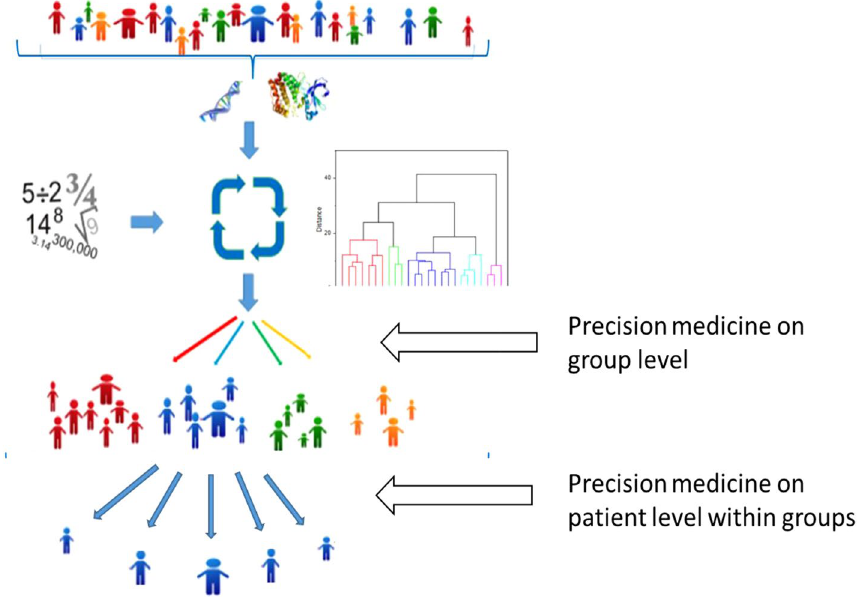
Figure 8. The ER modelling approach applied to precision medicine. In the present study we separated the participants into groups based on abundance of molecular markers and then analysed the data both within each group and across all participants using ER modelling to isolate the effects of group and to identify a disease- specific protein pattern. ER modelling can be utilized for precision medicine on group level to optimize therapy for patients in each group and to guide personalised medicine decisions within groups and likewise for other heterogenous